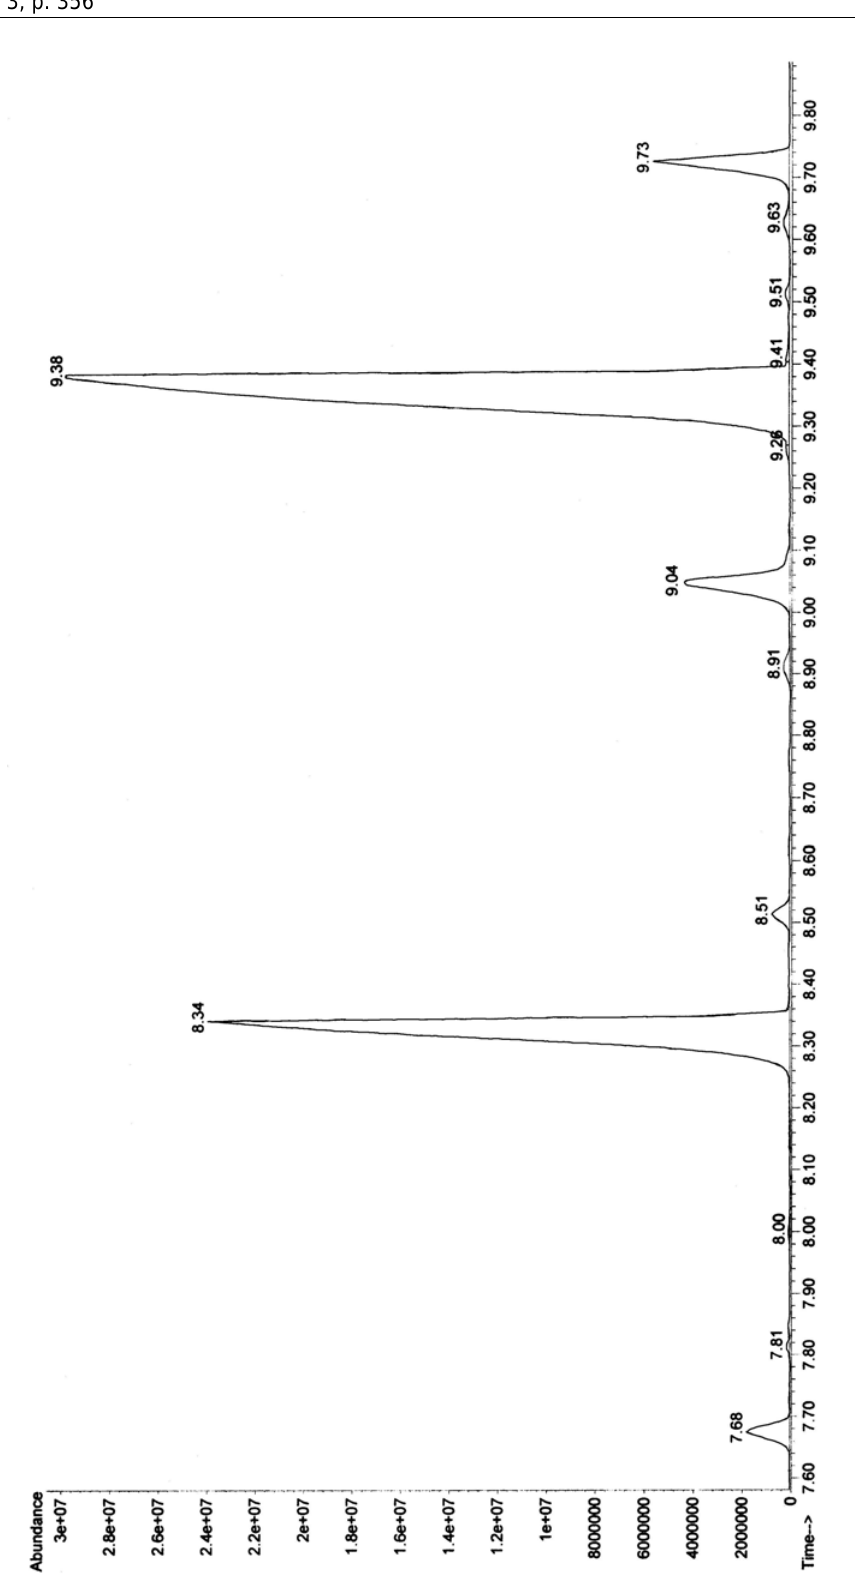
Figure 1b: Gas chromatograms of lecithin hydrolysate obtained in presence of vipoxin 1 mmol/l (b). (Incubation time: 25 min at the conditions described in the text). t =8.36 Internal Standard (Heptadecanoic acid, 17:0); t acid (16:0); t R t =9.06 Oleic acid (18:1); t =9.39 Linoleic acid (18:1); t R R